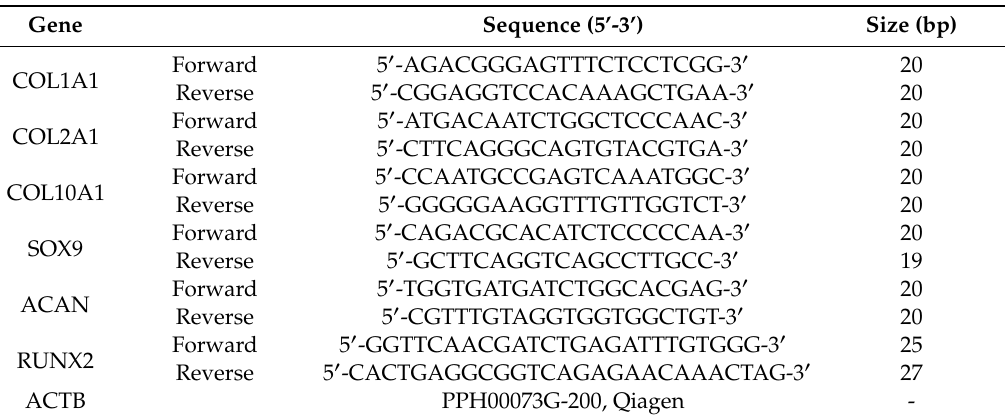
Table 1. qRT-PCR primer